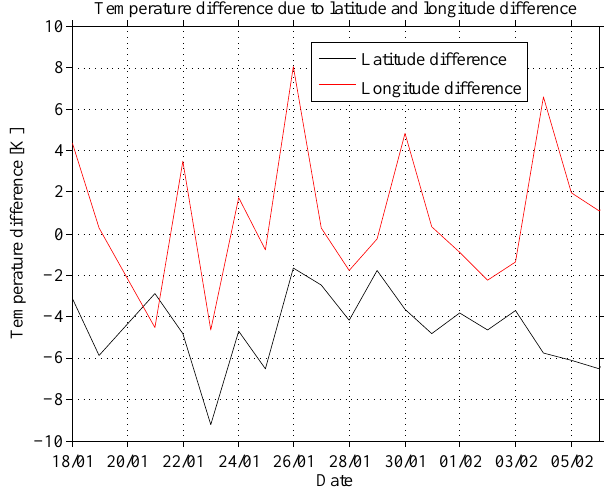
Fig. 7. Temperature difference between different sites due to lat- Fig.7. Temperaturedifferencebetweendifferentsitesduetolatitudeandlongitudedifference. Theblackcurve itude and longitude difference. The black curve shows the MLS shows the MLS observed mesopause temperature difference between the Wasa site and a a site at the same observed mesopause temperature difference between the Wasa site longitudeasWasaandthesamelatitudeasDavis. TheredlineshowsthetemperaturedifferencebetweenWasa and a a site at the same longitude as Wasa and the same latitude and a site at the same latitude as Wasa and the same longitude as Davis. MLS temperature data from three as Davis. The red line shows the temperature difference between pressurelevelscorrespondingtoapproximatealtitudesof83to89kmwereused. Wasa and a site at the same latitude as Wasa and the same longi- tude as Davis. MLS temperature data from three pressure levels corresponding to approximate altitudes of 83 to 89 km were